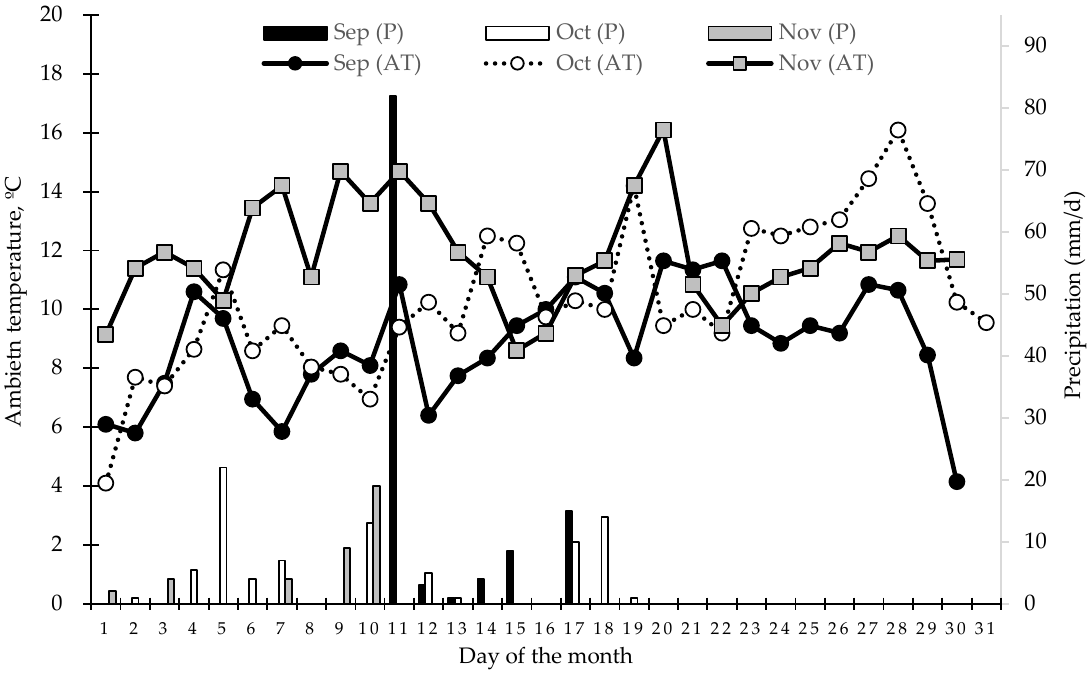
Figure 1. Records of ambient temperature (AT, lines, at the left axis) and daily rain precipitations (P, bars, at the right axis) for the study period. Data provided by the meteorological station of Cranberries Austral Chile S.A., located 3.5 km from the study location.